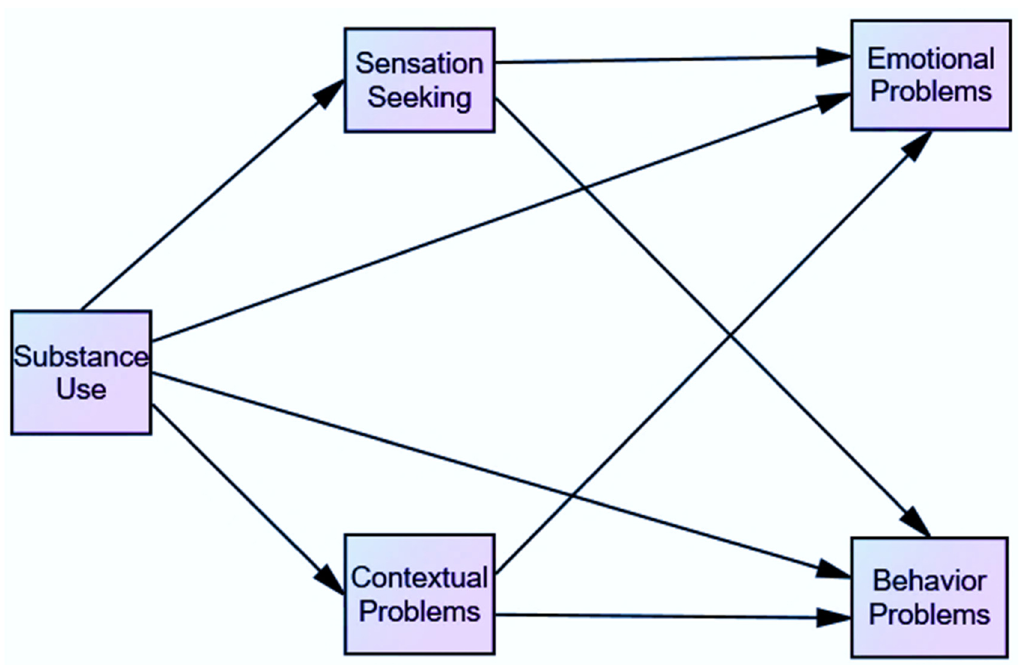
Figure 1. Proposed model of substance use on emotional and behavior problems.